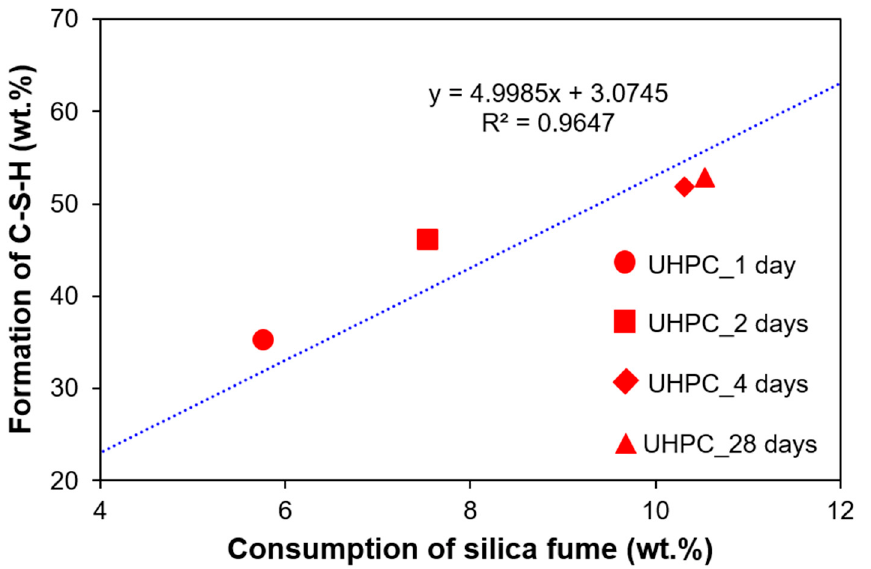
Figure 12. Relationship between consumption of silica fume and formation of C-S-H .